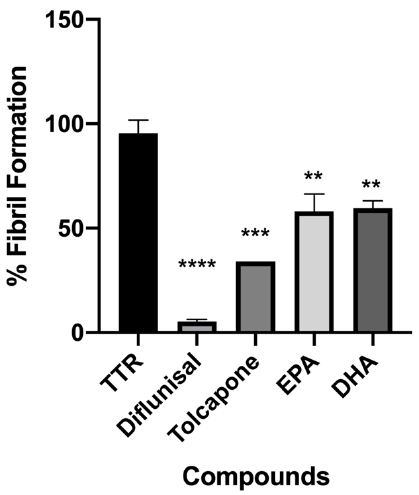
Figure 3. In vitro acid denaturation mediated of wt-TTR. The FF in absence of any inhibitor was assigned to be 100%. Results are shown as mean ± SEM. Statistical significance is calculated by one- way ANOVA test and Turkey post hoc test: * indicates significant difference vs. TTR (**** p < 0.0001, *** p < 0.001 and ** p < 0.01).